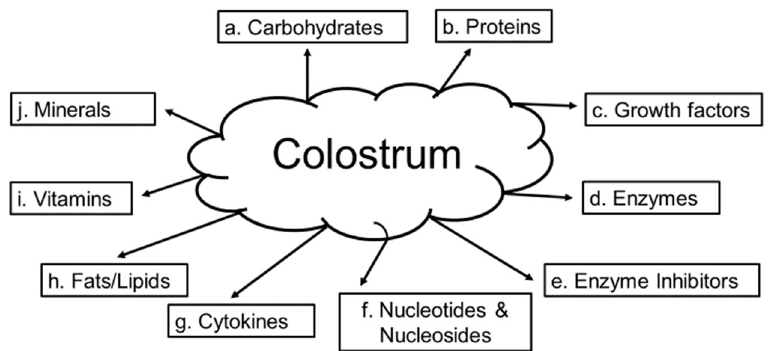
Figure 4. Colostrum or “first milk” is produced by mammals (including humans)